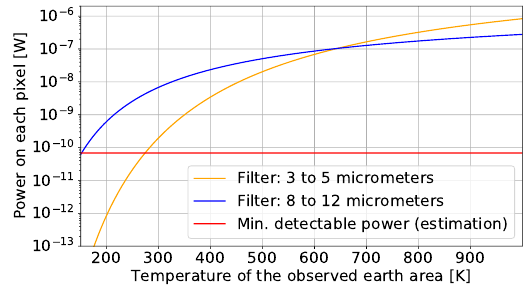
Figure 3. Simulation of incident power on each pixel of the thermal imager as a function of earth’s soil temperature.